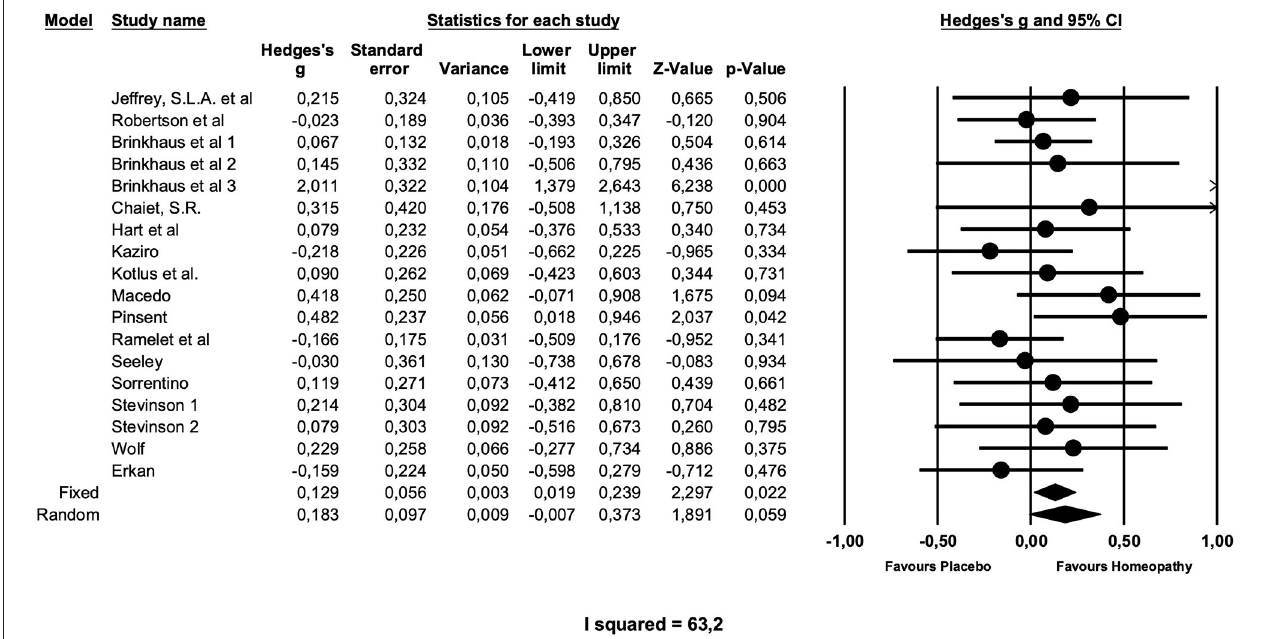
FIGURE 2 | Forest plot of main meta-analysis of placebo-controlled trials of arnica in postoperative complications.